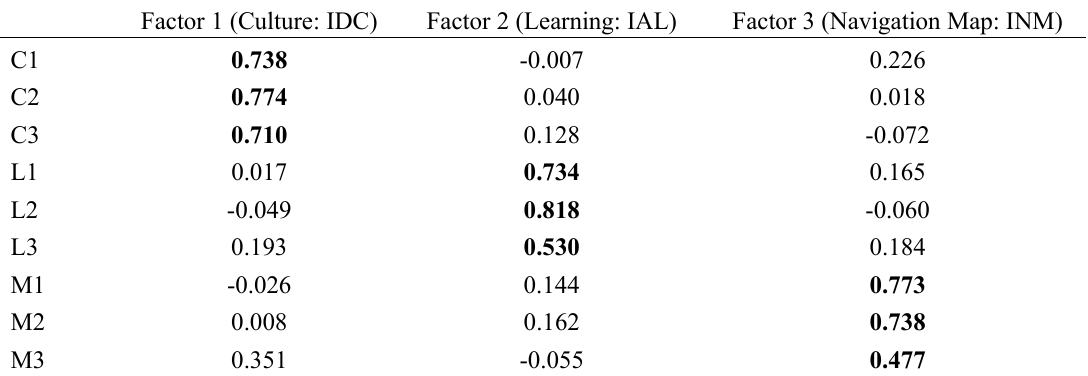
Table 1. Results of Factor Analysis for Culture, Learning and Navigation Map